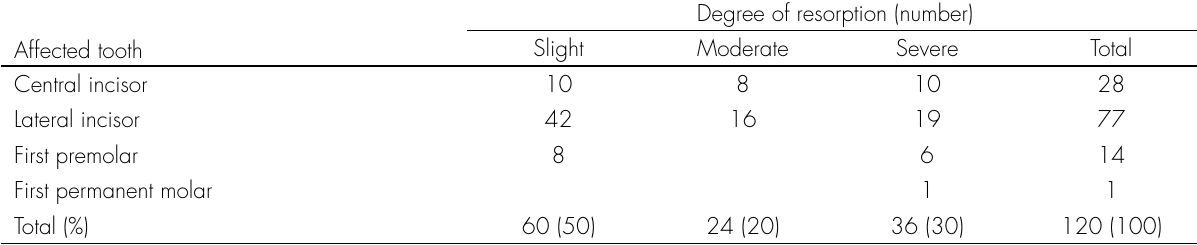
Table VI. Studies using 3D radiography to investigate the presence of resorption of adjacent teeth in relation to impacted maxillary canine teeth.